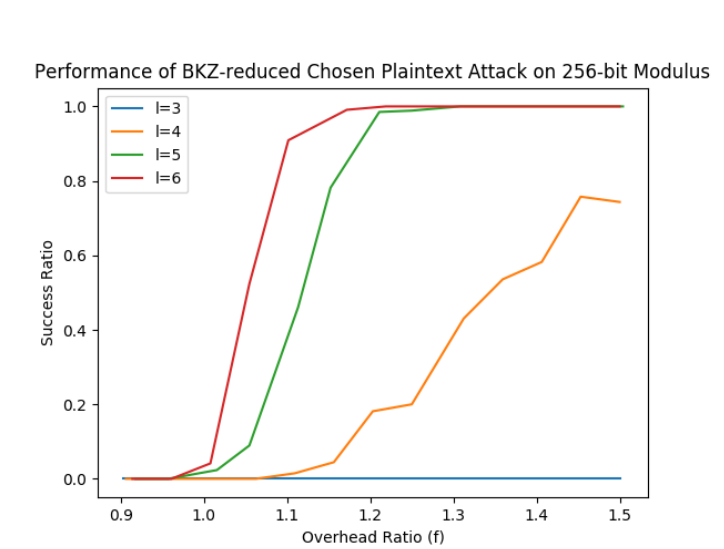
Figure 2: Performance of BKZ reduction algorithm when solving the HNP for a 256 bit modulus. This data is for the chosen-plaintext attack, and the BKZ block size is 15. For each value of l , the reduction fails for f < 1. However, for f > 1, the odds of success rise at different rates.